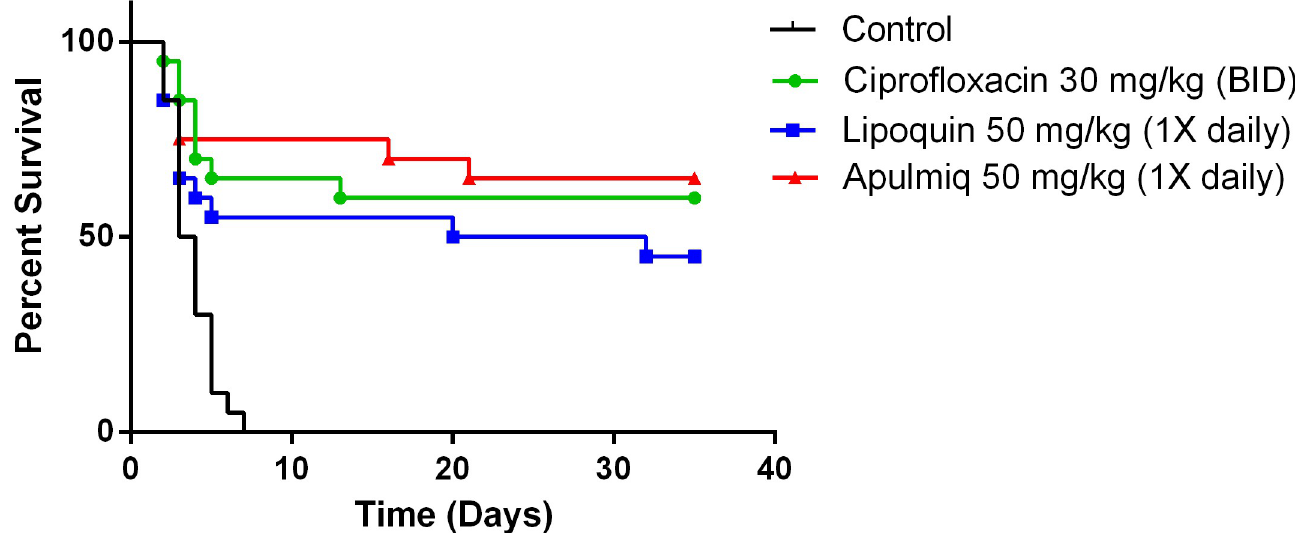
Fig 2. The efficacy of ciprofloxacin, lipoquin and apulmiq was evaluated in a treatment model after a lethal B . anthracis Ames challenge. Balb/c mice were challenged with 10 LD 50 of B . anthracis Ames, and were treated as described, 48 hours after exposure for seven days. Efficacy of mice (n = 5x3) versus PBS-treated control mice was evaluated. Therapeutic efficacy of intraperitoneal delivered ciprofloxacin (b.i.d.) and intranasal delivered apulmiq and lipoquin (once daily) were compared. All treatments improved survival compared to PBS (P <